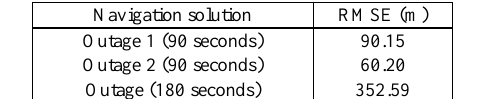
Figure 21. INS standalone trajectory for 180 seconds GNSS signal outage